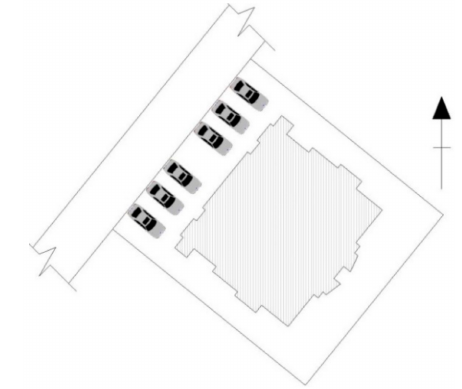
Figure 6. Site plan of the simulated